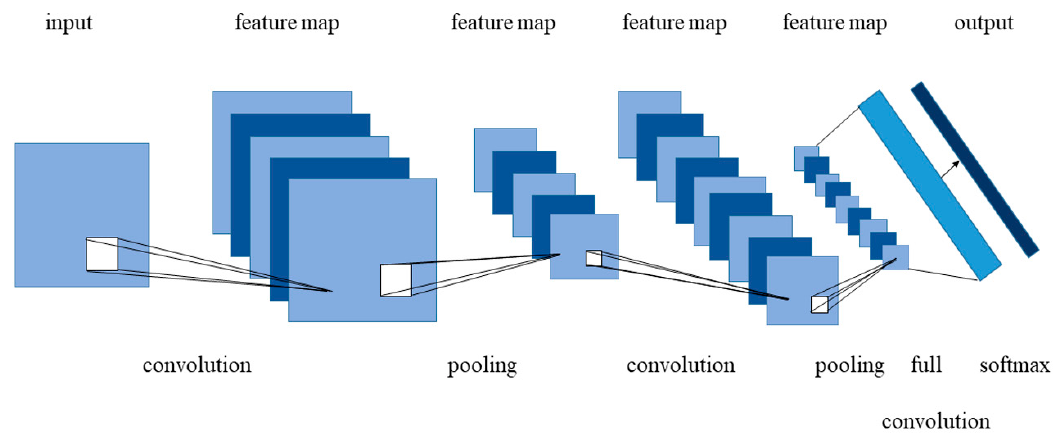
Figure 4. Overall architecture of Convolution Neural